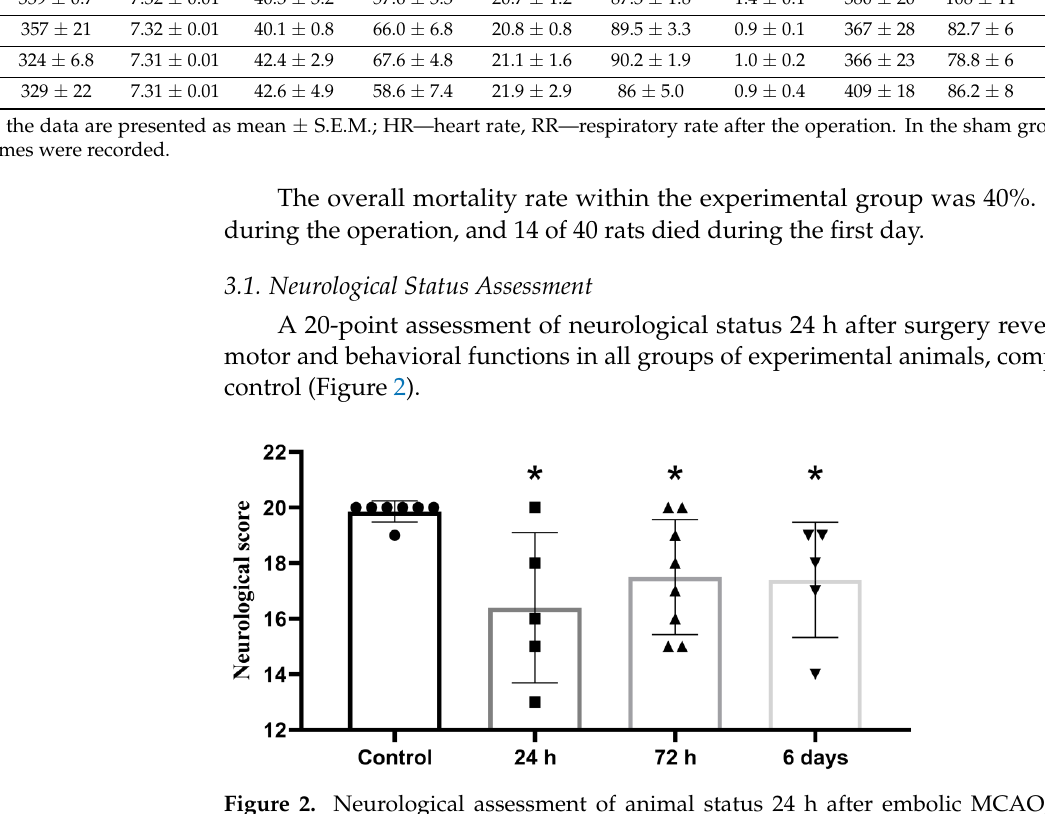
Figure 3. Decrease in neurological status in post stroke period persisted for 5 days after MCAO. The 20-point scale, *— significant difference vs. control ( p ≤ 0.05. Wilcoxon W-criterion). The data are presented as mean with standard deviation. 3.2. Histology Histological examination revealed no areas of brain tissue damage in the sham- operated rats in the ipsilateral or contralateral hemisphere (Figure 4a,b). In 16 of 24 animals (67%) of the experimental group, tissue edema and necrosis were observed in the left middle cerebral artery supply area, i.e., striatum, cortex, and hippocampus. The remaining animals had separate foci of damaged neurons in the cortex and hippocampus. The parietotemporal cortex (seven animals), hippocampus (nine animals), striatum, and thalamic region (nine animals) were most frequently affected. The study of brain sections at different periods after MCAO revealed necrotic foci of varying severity in the cortex and subcortical regions of the ipsilateral hemisphere, after 6 h—in one of four animals, after 24 h—in six of seven rats (Figure 4c,d), after 72 h—in five of eight rats (Figure 4e,f), after 6 days—in four of five rats (Figure 4g,h).